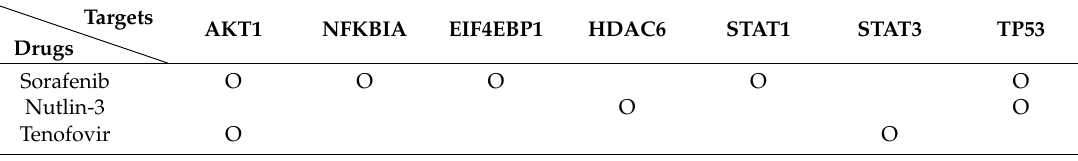
Table 7. Potential multiple-molecule drug and the corresponding target genes for HBV infection therapy. Targets